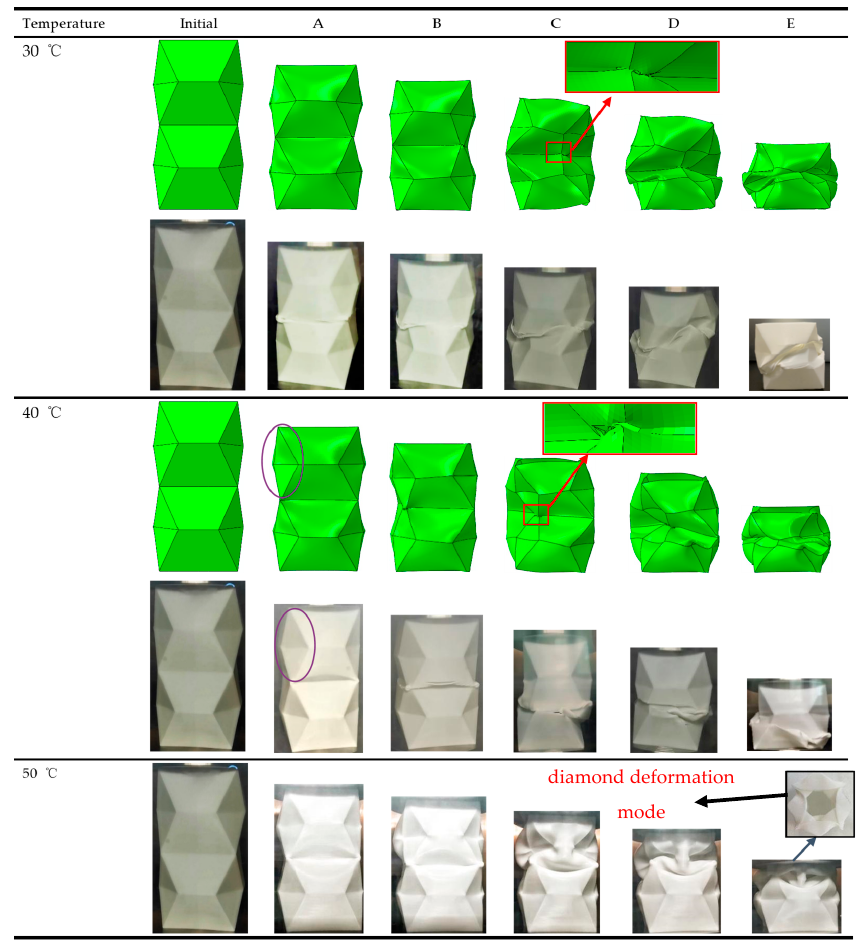
Figure 9. Force-displacement curves of OCB: ( a ) experimental force-displacement curves; ( b ) nu- merical force-displacement curve.